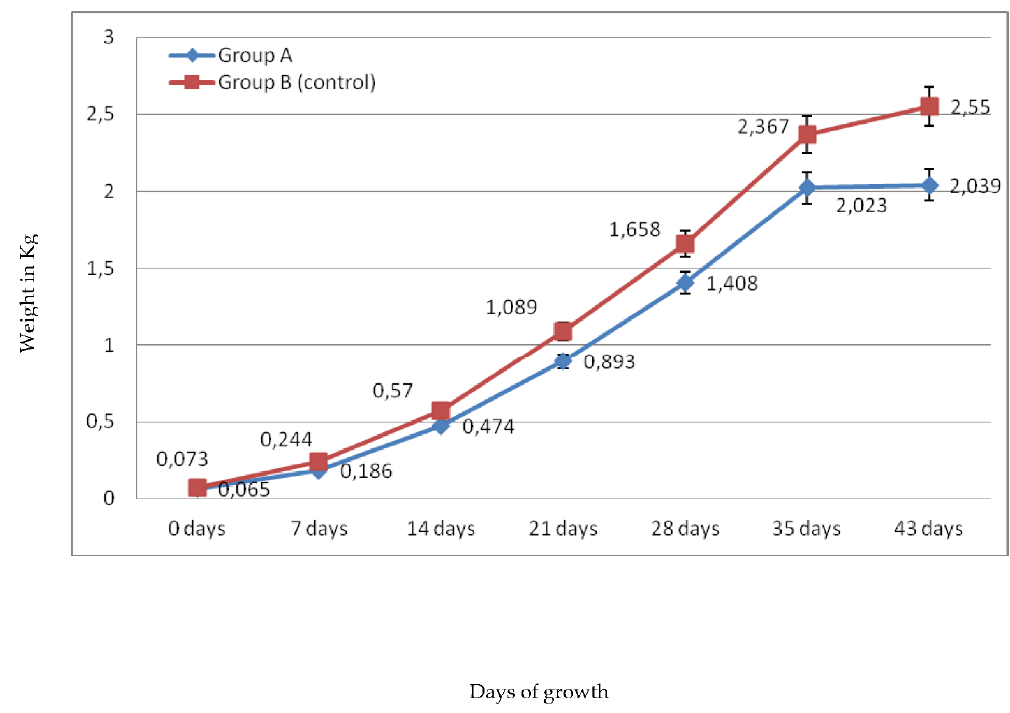
Figure 1. Broiler average weight after 43 days of growth. Broilers of group A, fed with ration supplemented with pulp and seeds of pomegranate and avocado by-products, and broilers of group B (control group), fed with basal ration.